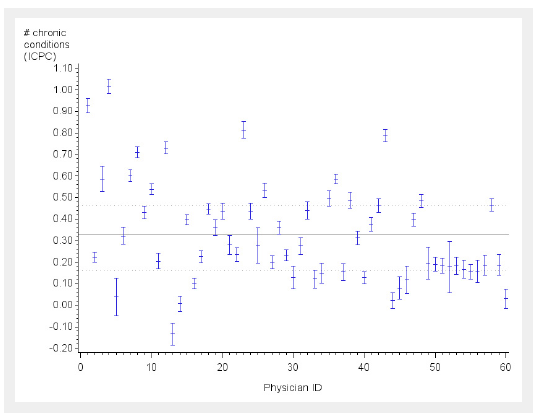
Table 1 documents the respective associations.